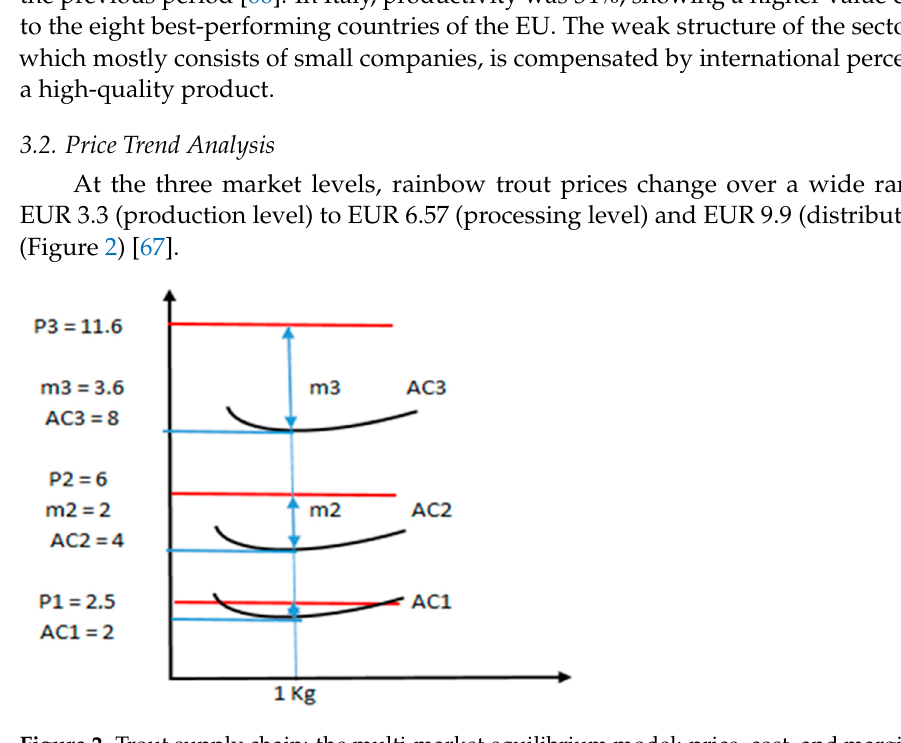
Figure 2. Trout supply chain: the multi-market equilibrium model: price, cost, and margin per 1 kg of product.